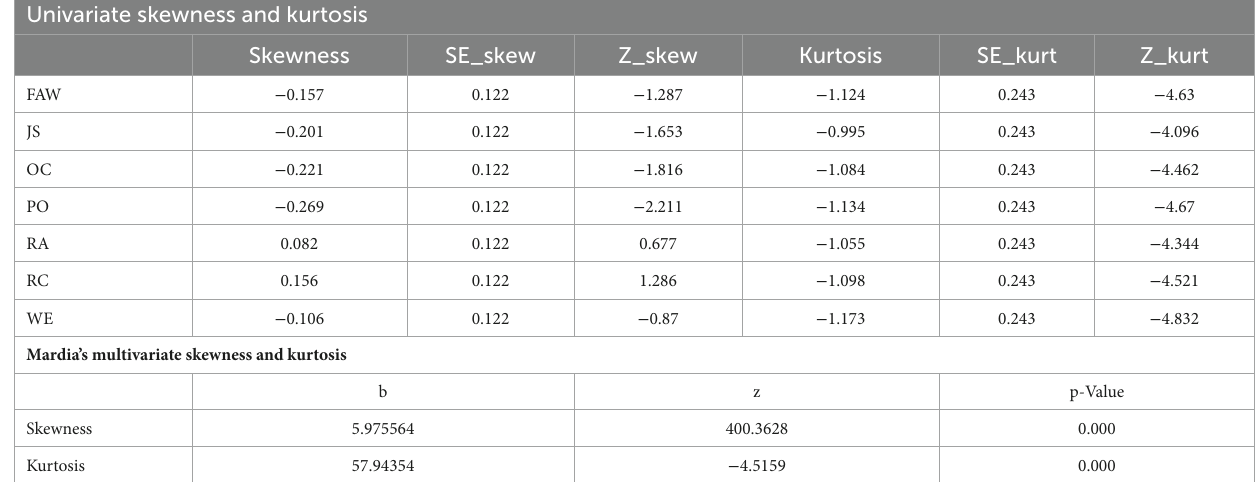
TABLE 1 Skewness and Kurtosis analysis. Univariate skewness and